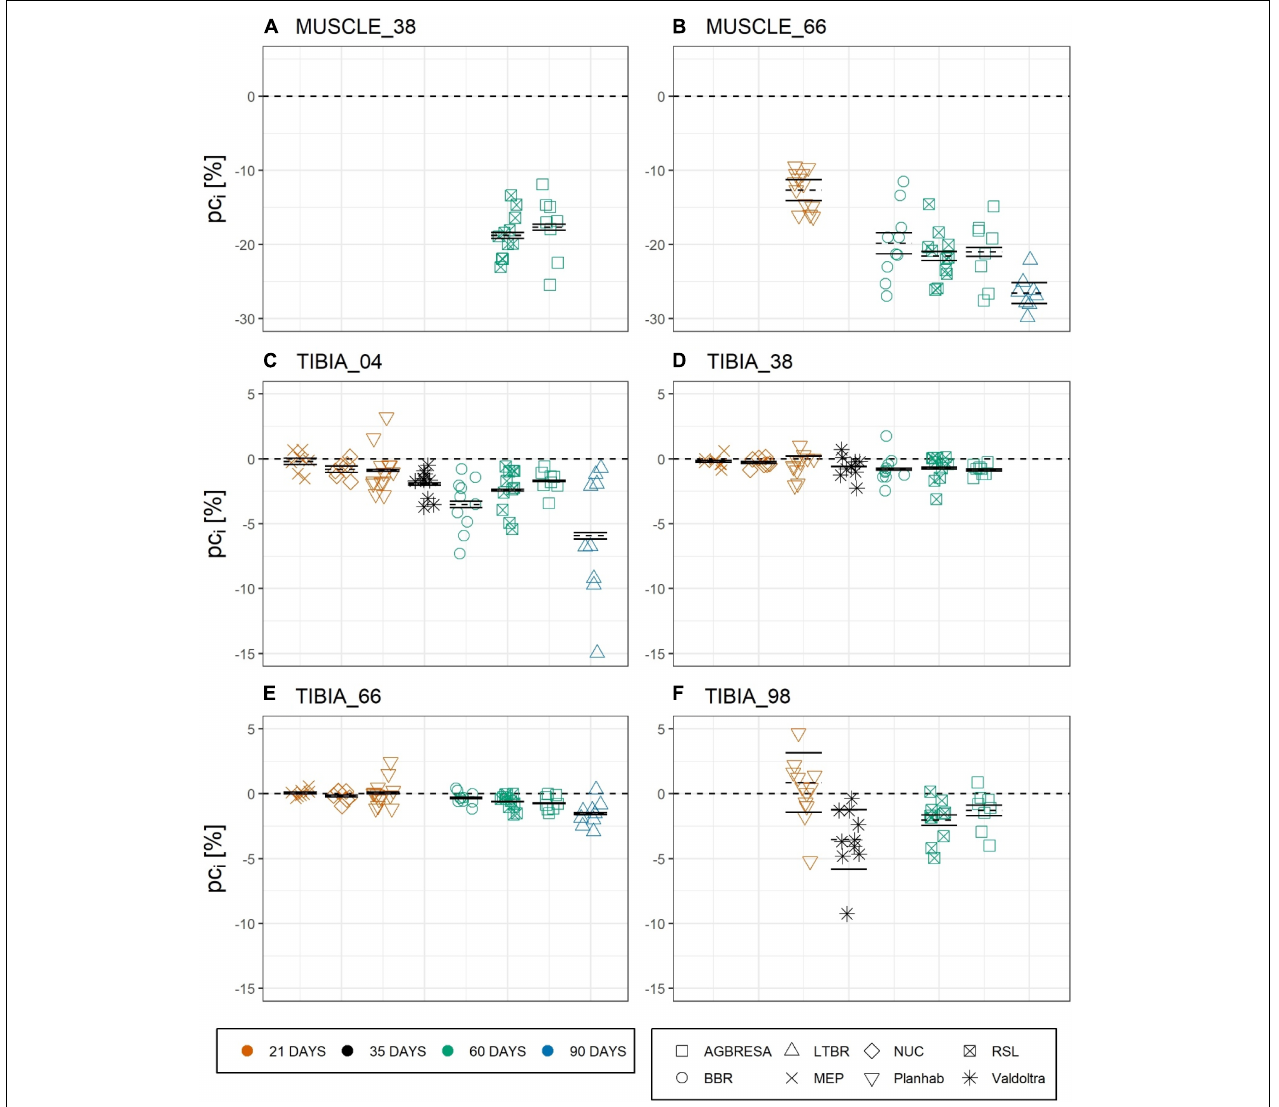
FIGURE 3 | Chart of the individual percent change (pc i ) by measurement sites with (A) CSA at MUSCLE_38, (B) CSA at MUSCLE_66, (C) BMC at TIBIA_04, (D) BMC at TIBIA_38, (E) BMC at TIBIA_66, and (F) BMC at TIBIA_98, where the numbers indicate the relative measurement position regarding the entire tibia length from distal to proximal. The color indicates the bed rest duration and the shape represents the study. Each chart is separated by the studies, who performed measurements at the measurement site. Mean of the pc as dashed line, upper and lower limit of the 95%-confidence interval based on measurement uncertainty U Meas as solid lines. The vast majority of pc i exceeds the confidence interval indicating significant and substantial between-subject